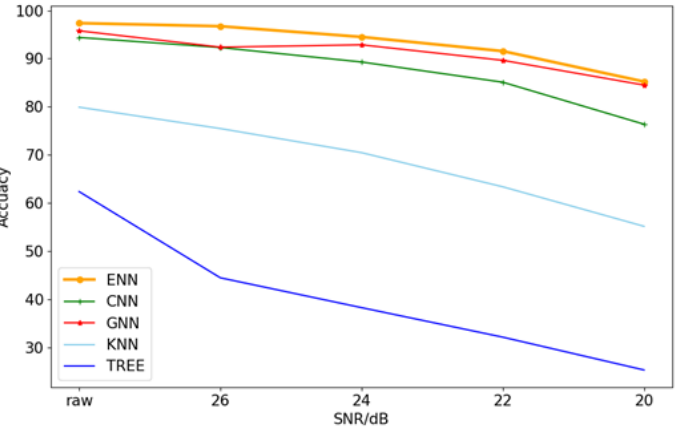
Figure 5. Accuracies of ENN and the comparison methods at various SNRs.